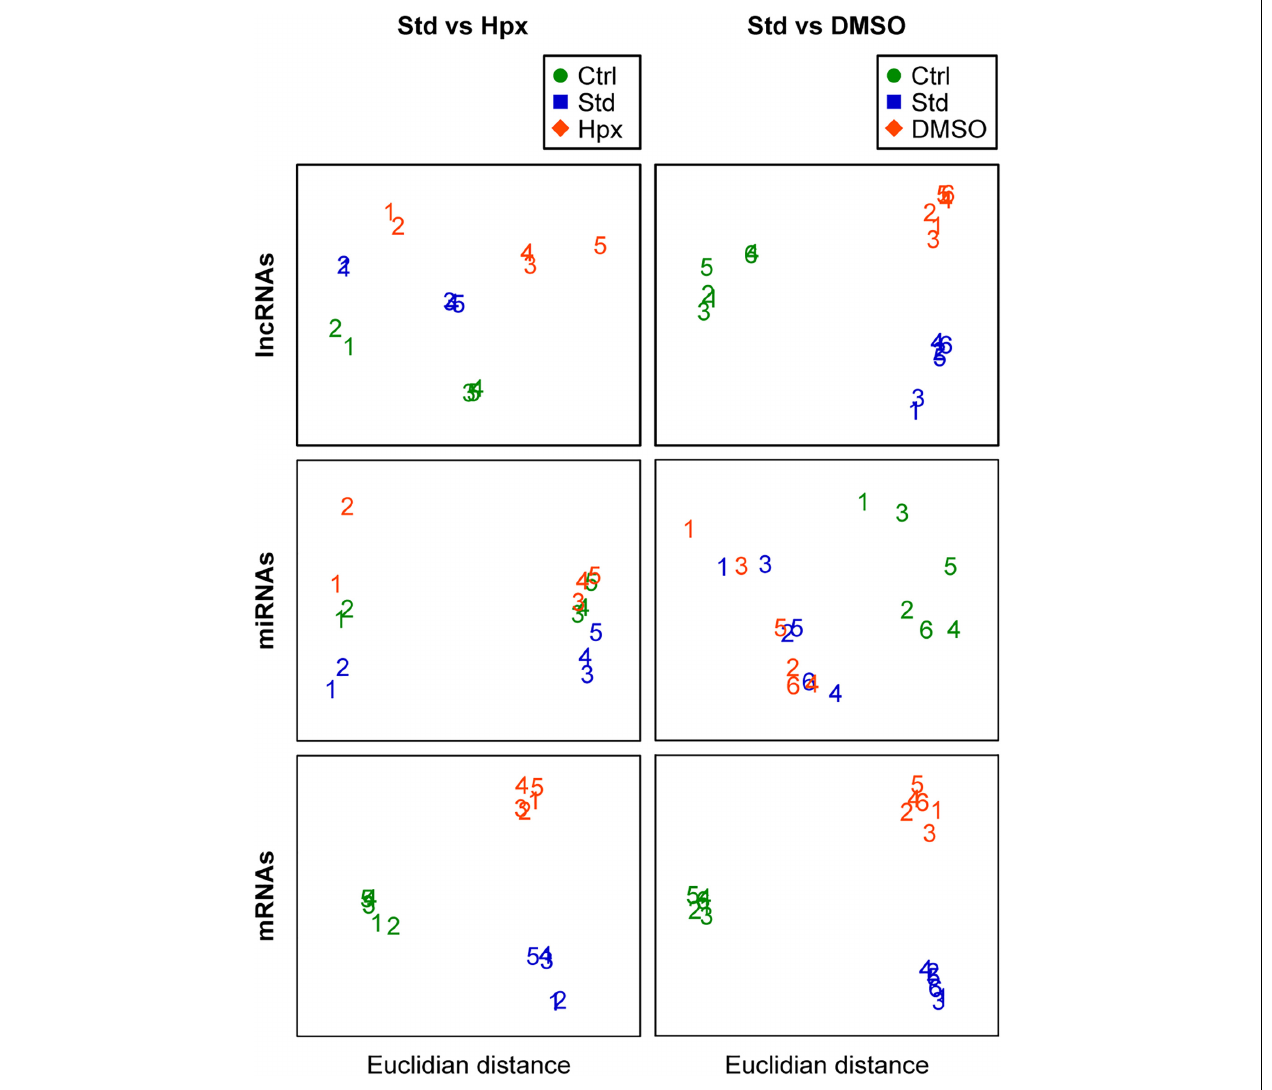
FIGURE 3 | Multidimensional scaling plots of RNAs in the two experimental sets. Classic multidimensional scaling plots of lncRNAs, miRNAs, and mRNAs were created using Euclidean distance as dissimilarity matrix across the samples. The cells were sequenced after plating (Ctrl), 48 h after culture in standard condition (Std) or after culture in hypoxia (Hpx) or in medium with added DMSO. The numbers in the plots represent each placental ID in the two exposure sets.